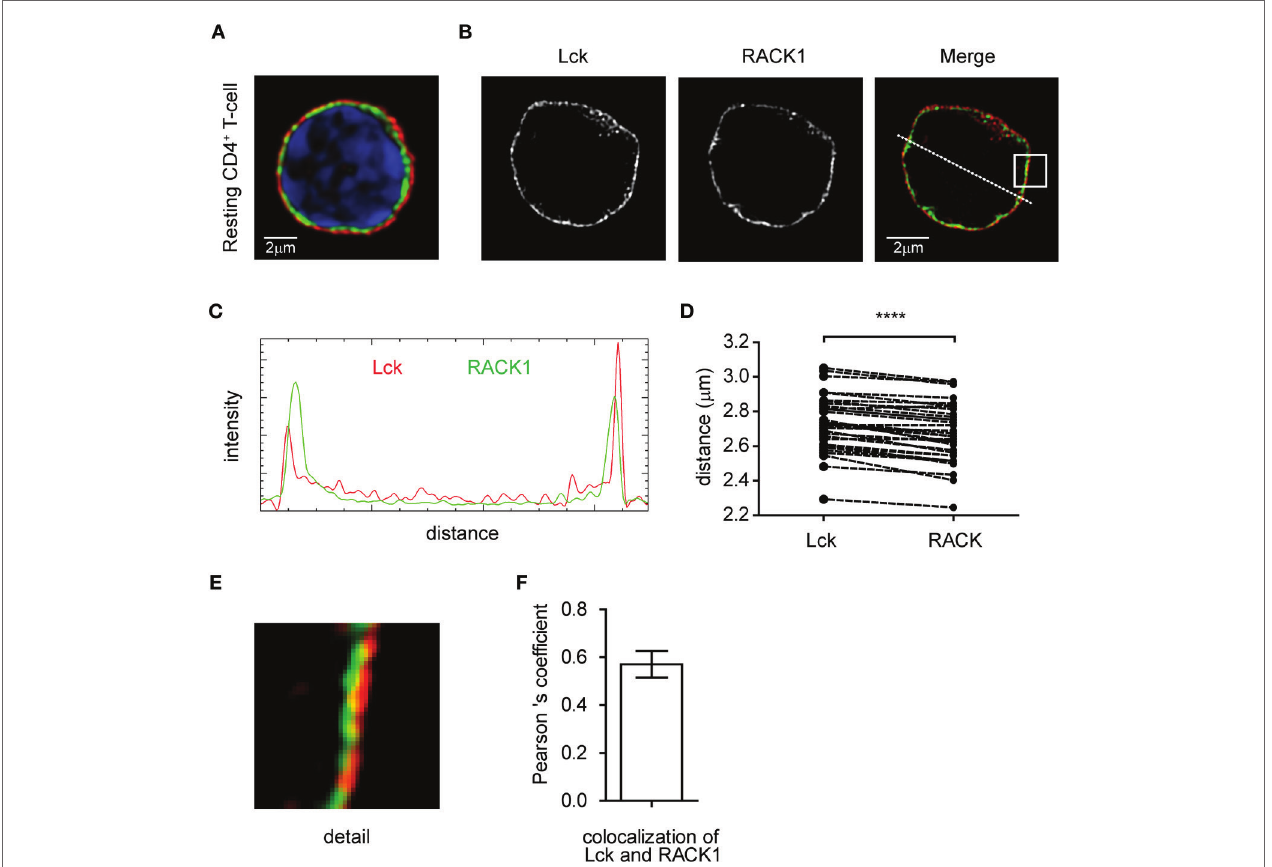
FigUre 1 | subcellular distribution of lck and racK1 in primary cD4 + T-cell . Fixed CD4 + T-cells were stained for RACK1 (green), Lck (red), and nuclei (blue) and visualized by confocal microscopy (a) or super-resolution N-SIM microscopy (B) . (c) Fluorescence intensity profile plot of Lck (red) and RACK1 (green) along the dotted line shown in the merged image of figure (B) . (D) Statistical analysis of the concentric juxtaposition of Lck and RACK1, which shows a larger distance of Lck from the cell centroid to its periphery ( n = 30), p ≤ 0.0001. (e) Magnification of the rectangle inset from the Merge image presented in (B) showing a subconcentrical juxtaposition of RACK1 to membrane-bound Lck. (F) The bar graph represents the statistical analysis of Lck and RACK1 colocalization using Pearson’s colocalization coefficient ( n = 20 cells). Error bars denote